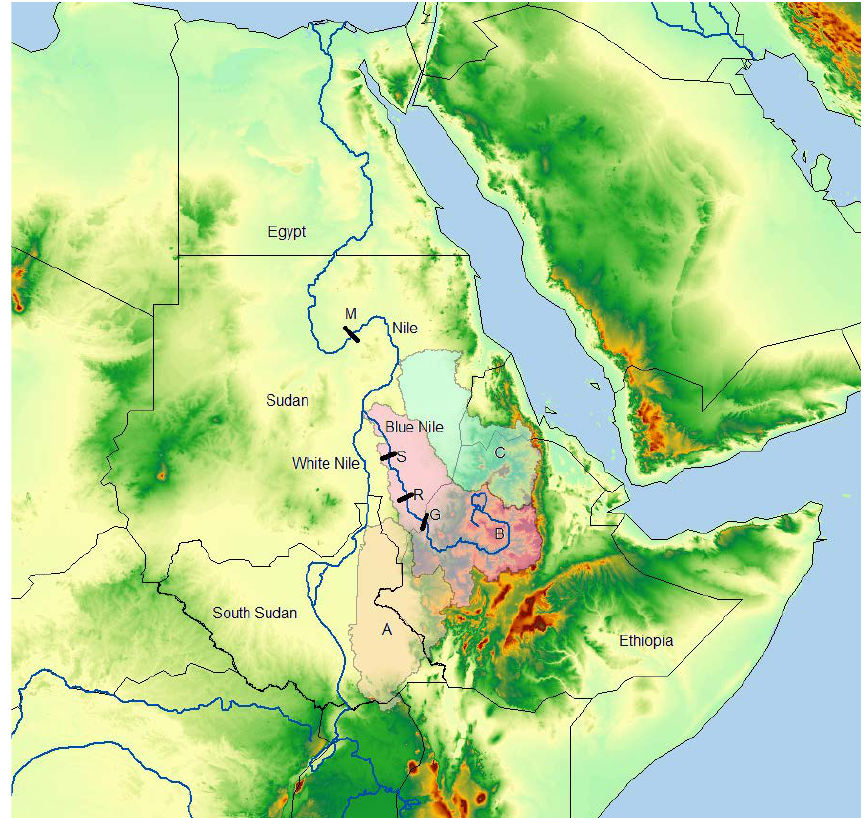
Figure 1. Map of the Nile and its tributaries: A = Baro–Akobo–Sobat, B = Blue Nile, C = Tekese–Atbara basins, S = Sennar Dam, R = Roseries Dam, M = Merowe Dam, and G =